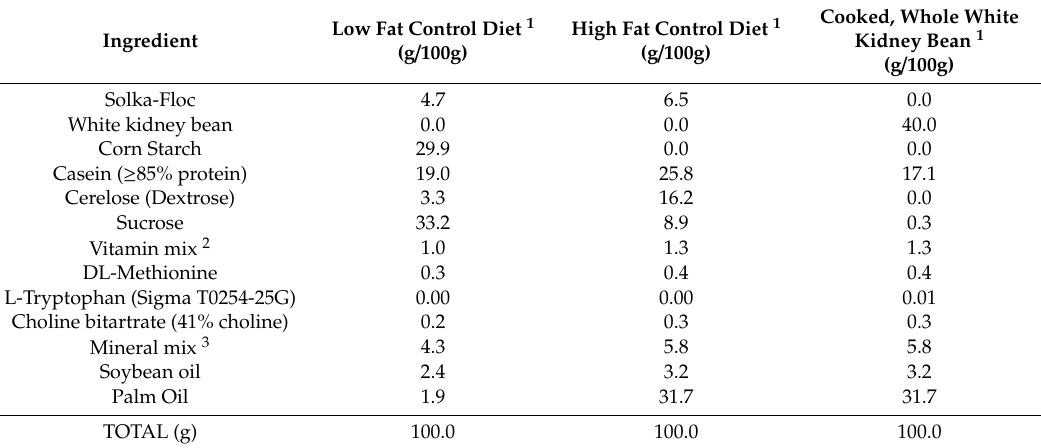
Table 1. Composition of Experimental Diets.